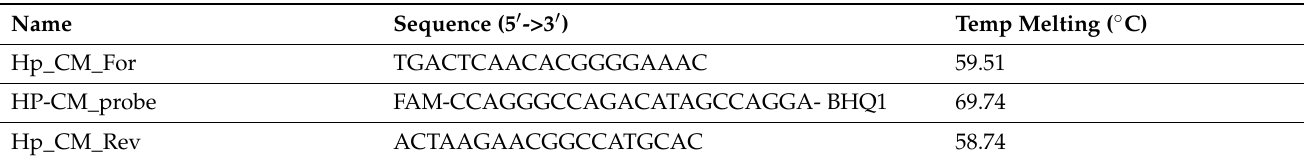
Table 2. Oligonucleotides and probe sequences for Haplosporisium pinnae 18SSU rRNA fragment and their melting